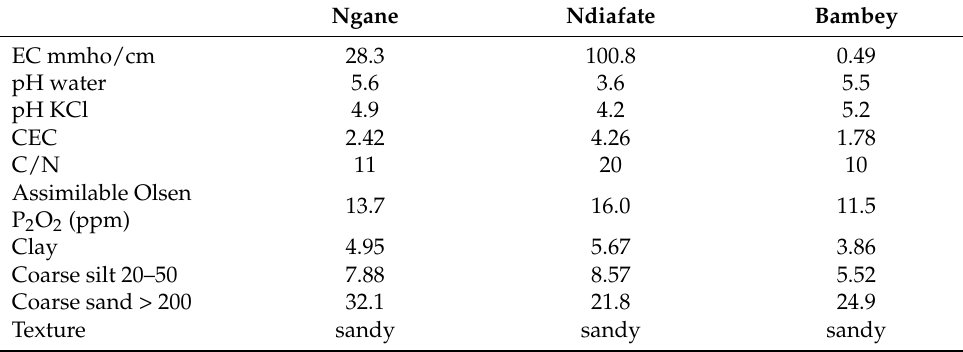
Table 1. Physicochemical properties of soils from the three sites, Ngane, Ndiafate, and